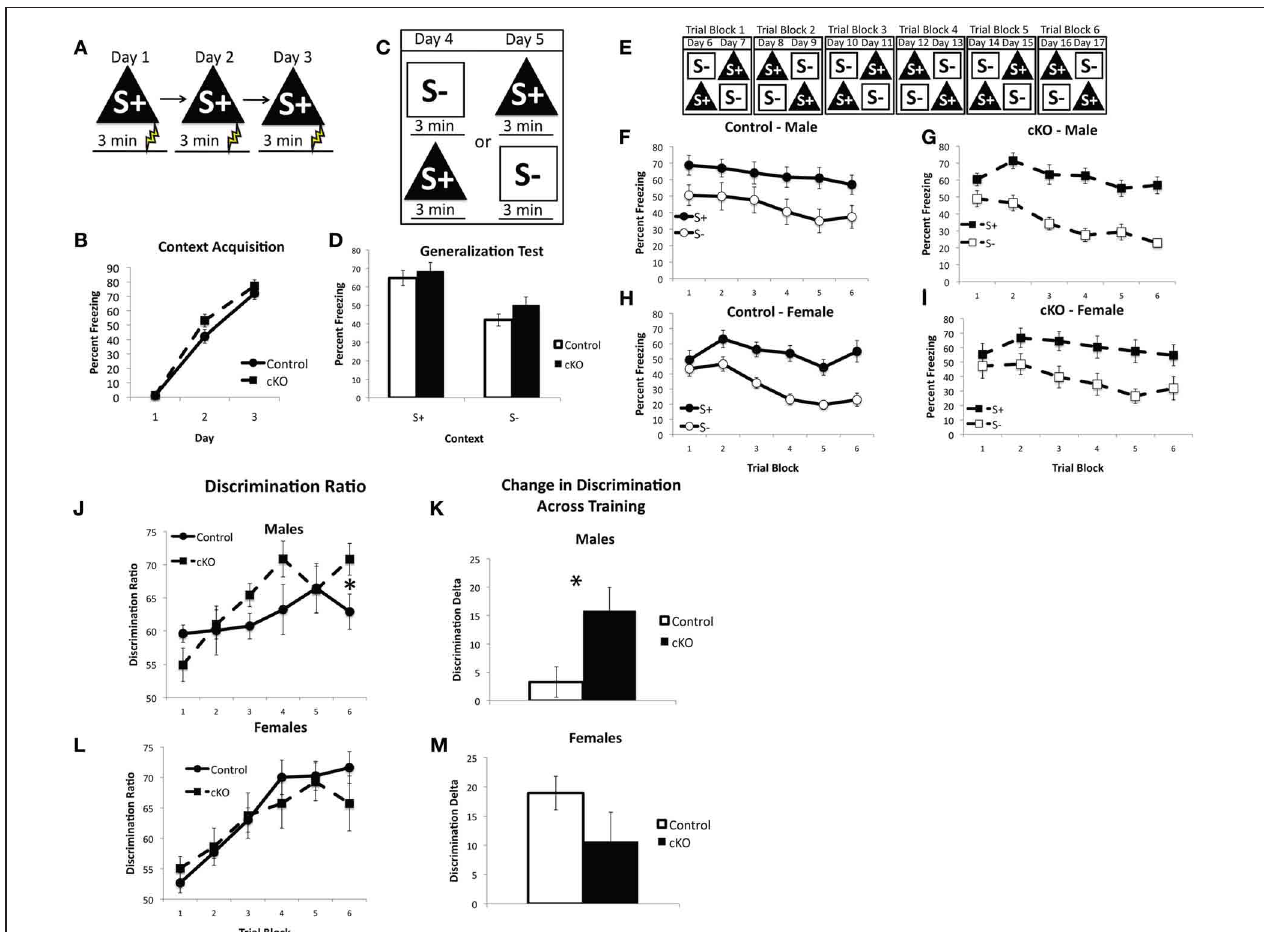
FIGURE 7 | DNMT1-cKO mice show a sex-specific enhancement in context discrimination learning. (A) Experimental design for the acquisition of fear to the S + context. Mice were placed in the conditioning chamber and shocked 3min later. (B) DNMT1-cKO mice show normal acquisition of contextual fear. (C) Experimental design for the generalization test. Mice were placed in both the S + and S − contexts over 2 days, with the order of exposure counterbalanced. (D) DNMT1-cKO mice show normal levels of freezing in the S + context as well as generalization to the S − context. (E) Experimental design for context discrimination training. Mice were placed in the S + context, where they received a foot-shock after 3min, and the S − context, where they never received a foot-shock, over the course of 12 days. Order of presentation followed a double alternation schedule and each 2 day period was averaged together to make six Trial Blocks. (F and G) Freezing in S + and S − across discrimination training in male control and